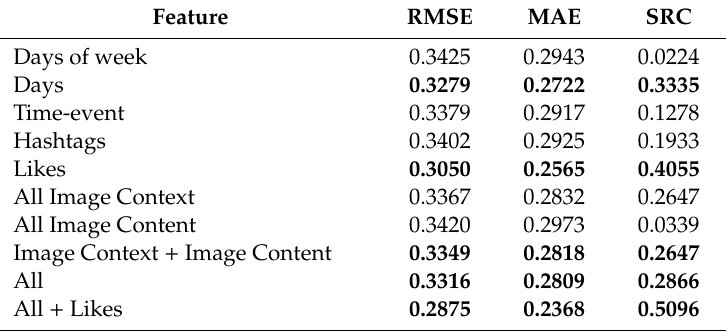
Table 6. Comparison of Comments Prediction using the gradient boosting machine (GBM) tree method with a di ff erent set of